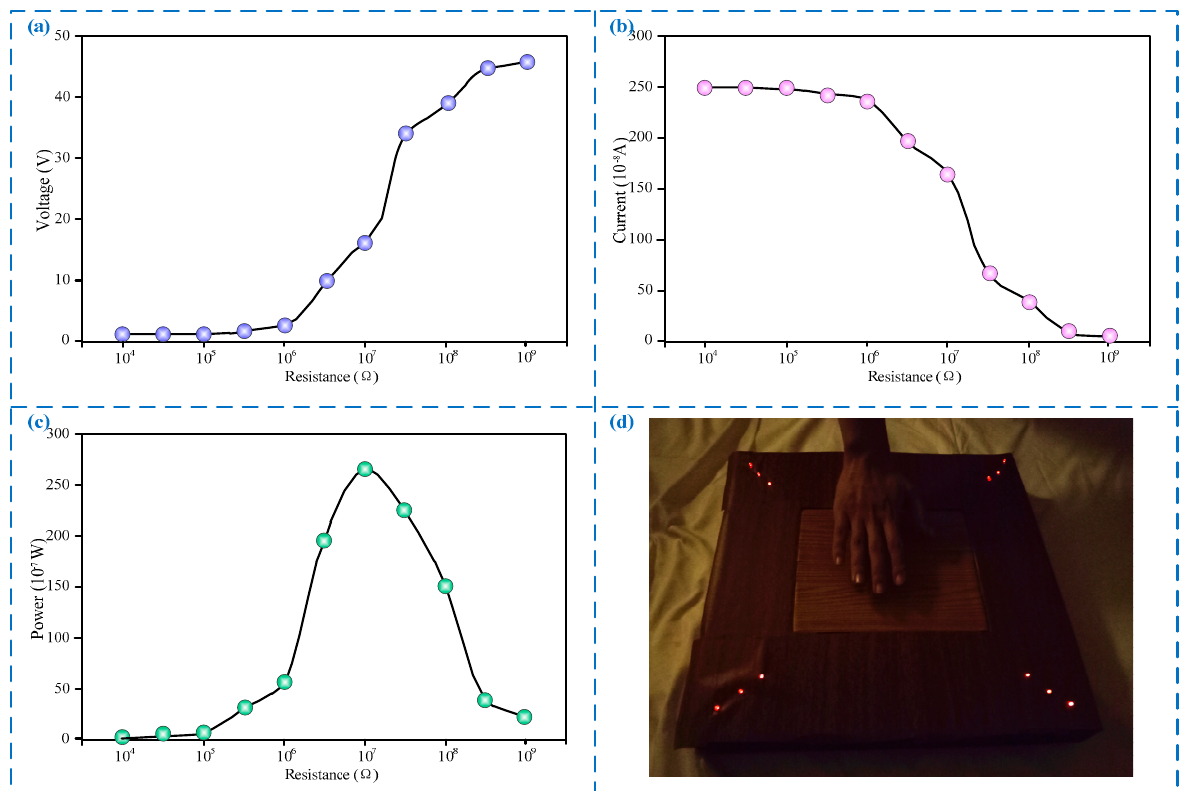
Figure 5. Power generation characteristics of the sensor. ( a ) Output voltage under different load resistance; ( b ) output current under different load resistance; ( c ) output power under different load resistance; ( d ) a picture shows the LED lights are lighted in real-time.